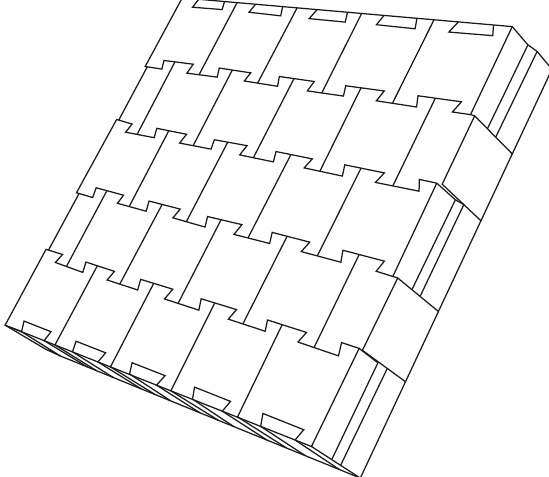
Figure 8: Schematic diagram of block after embedment.